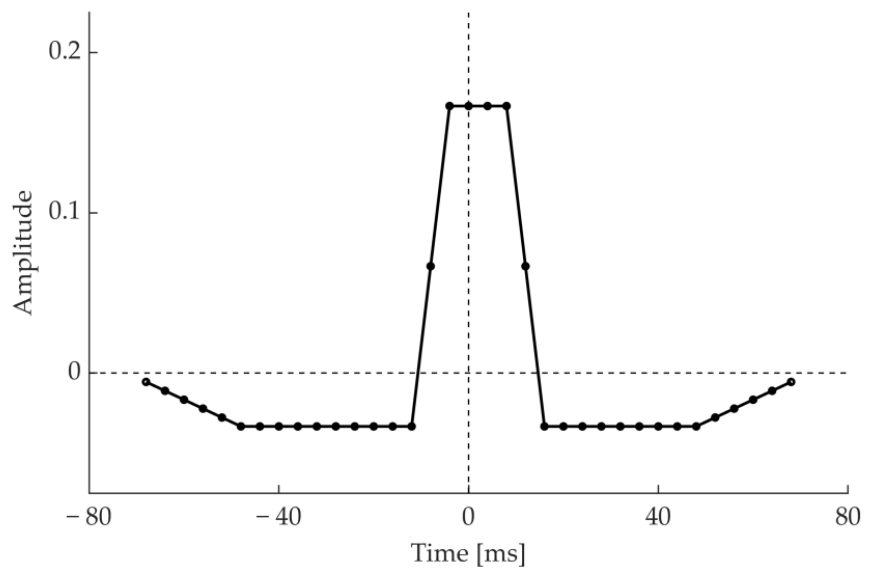
Figure 3. Impulsive response of MAC(0.02, 0.008)–MAC(0.12, 0.024) at a sampling frequency of 250 Hz.